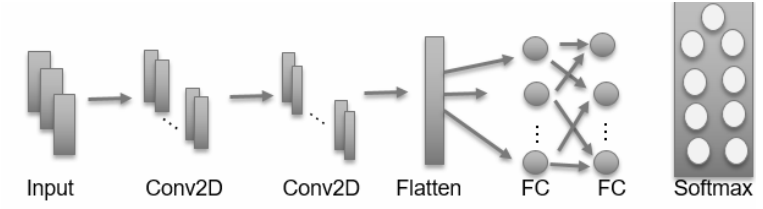
Figure 9. The CNN for this experiment has seven layers. The first convolution layer uses a kernel of 5 5 with a stride of one, the second convolution layer uses a kernel of 3 × and all activation functions are